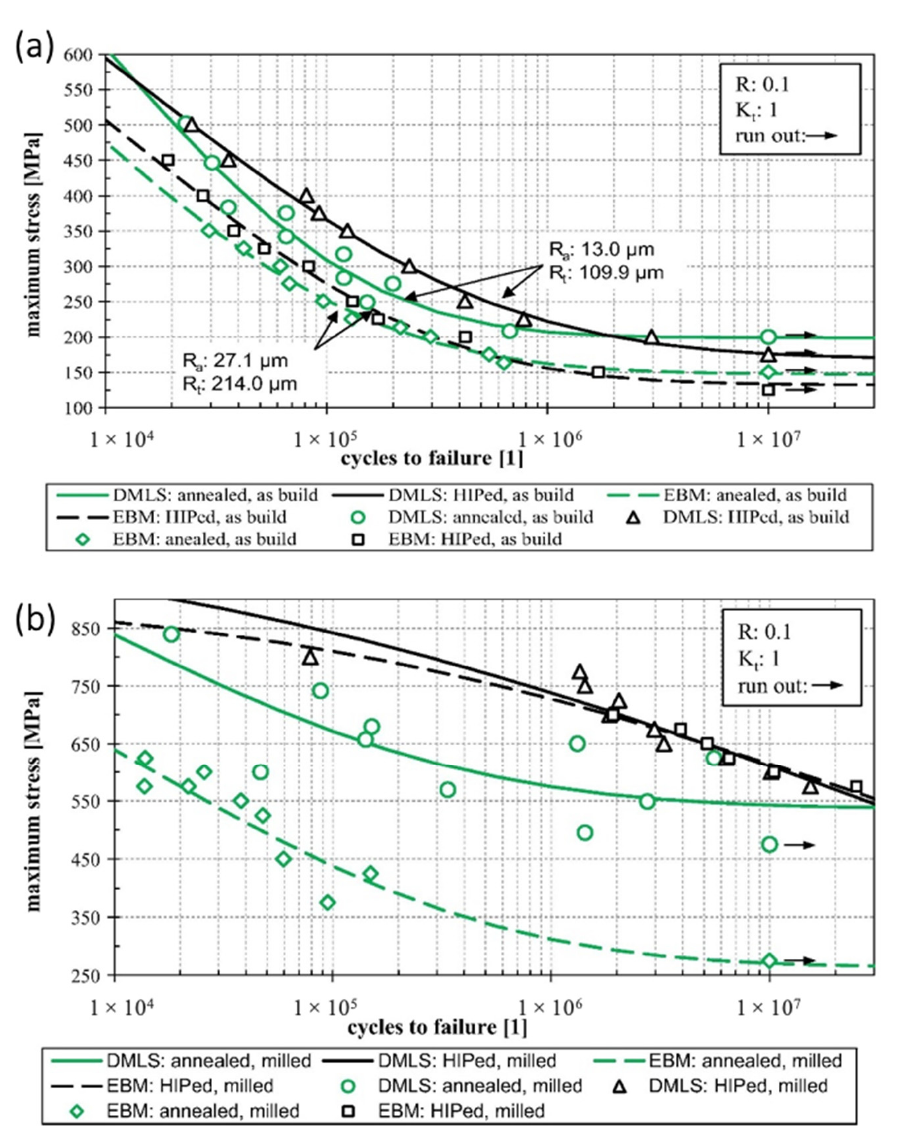
Figure 10. Fatigue properties of Ti6Al4V by LPBF and EBM for ( a ) as-built and ( b ) milled surfaces (adapted with permission from [21]. Copyright 2016 Elsevier).